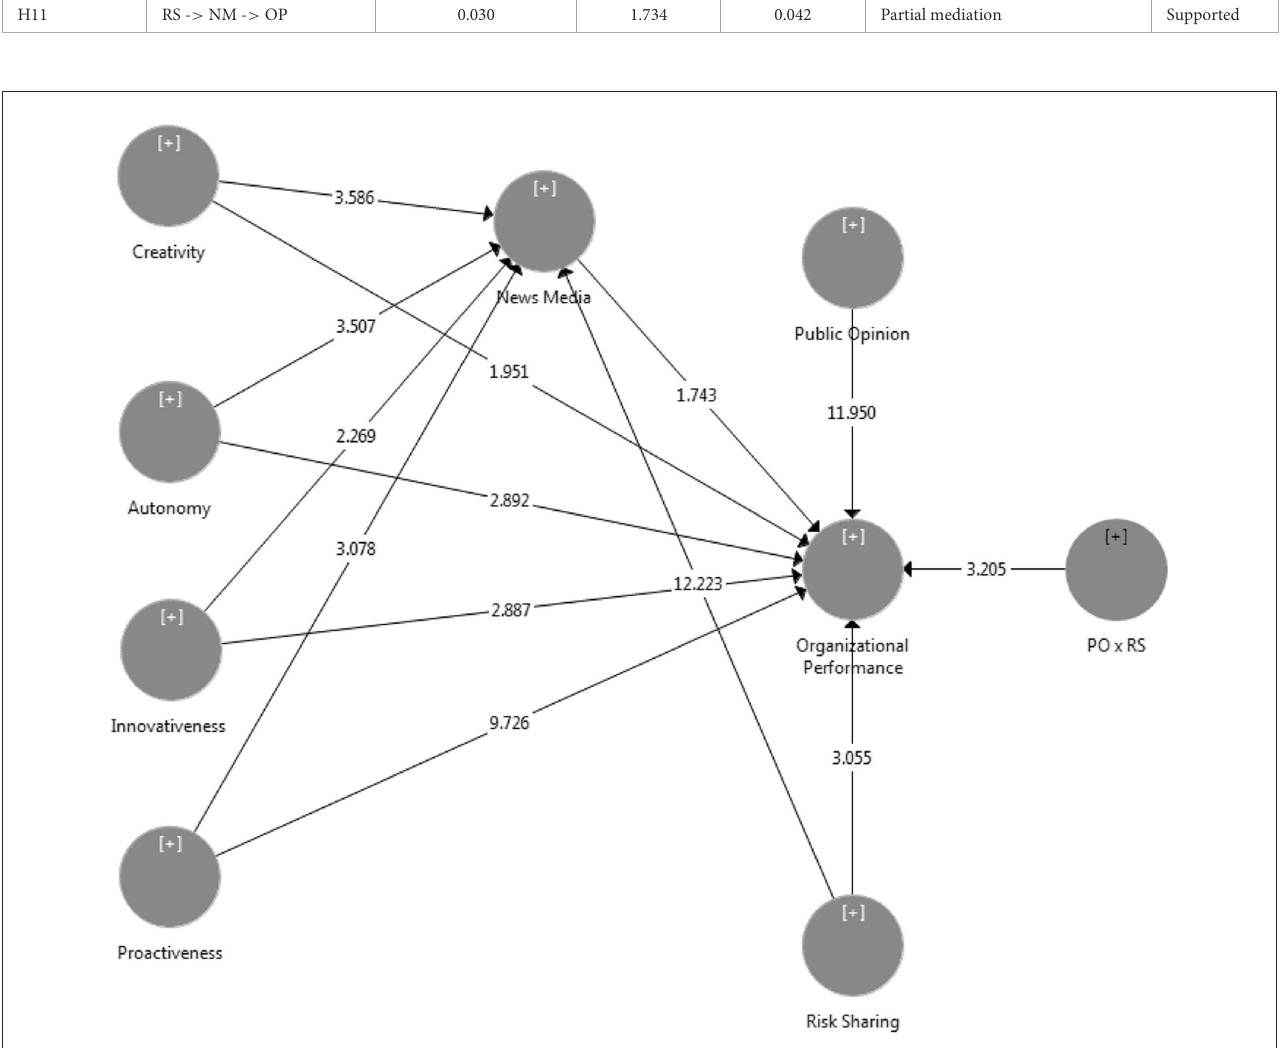
FIGURE4 Public opinion as a